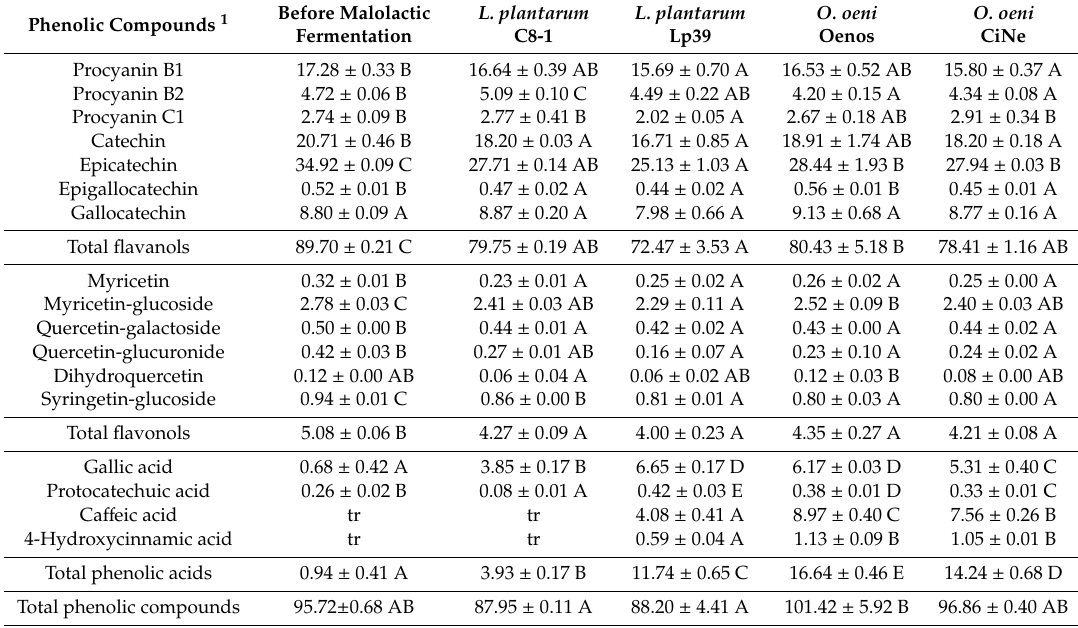
Table 1. Phenolic compounds in Cabernet Gernischt wine before and after malolactic fermentation using Lactobacillus plantarum (C8-1 and Lp39) and Oenococcus oeni (Oenos and